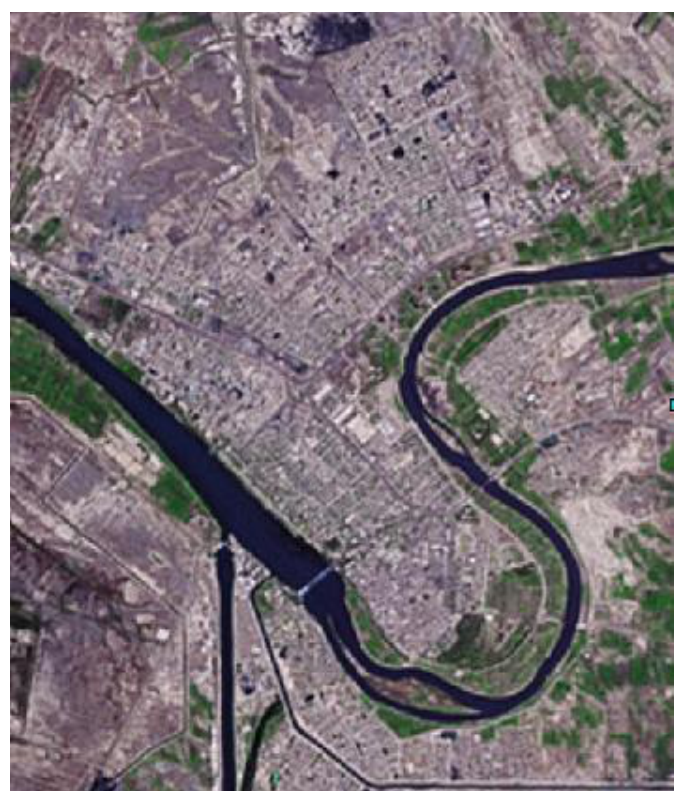
Fig.5: Producing Landsat satellite image with low